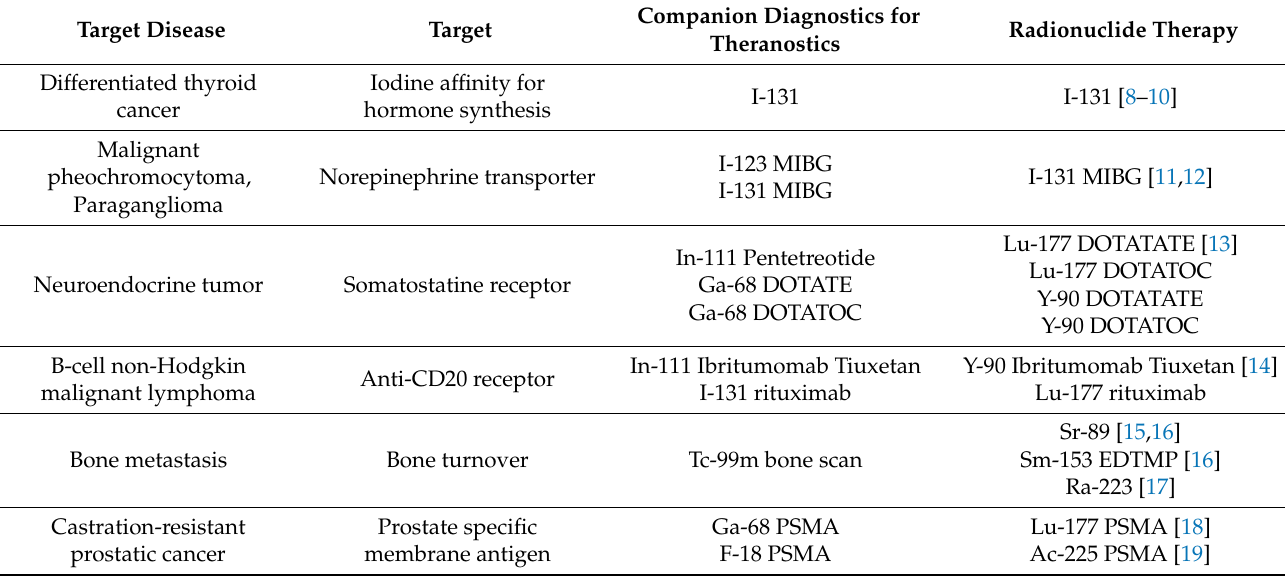
Table 1. Combination of diagnostic imaging and radionuclide with radiopharmaceuticals for the same target disease. Target Disease Target